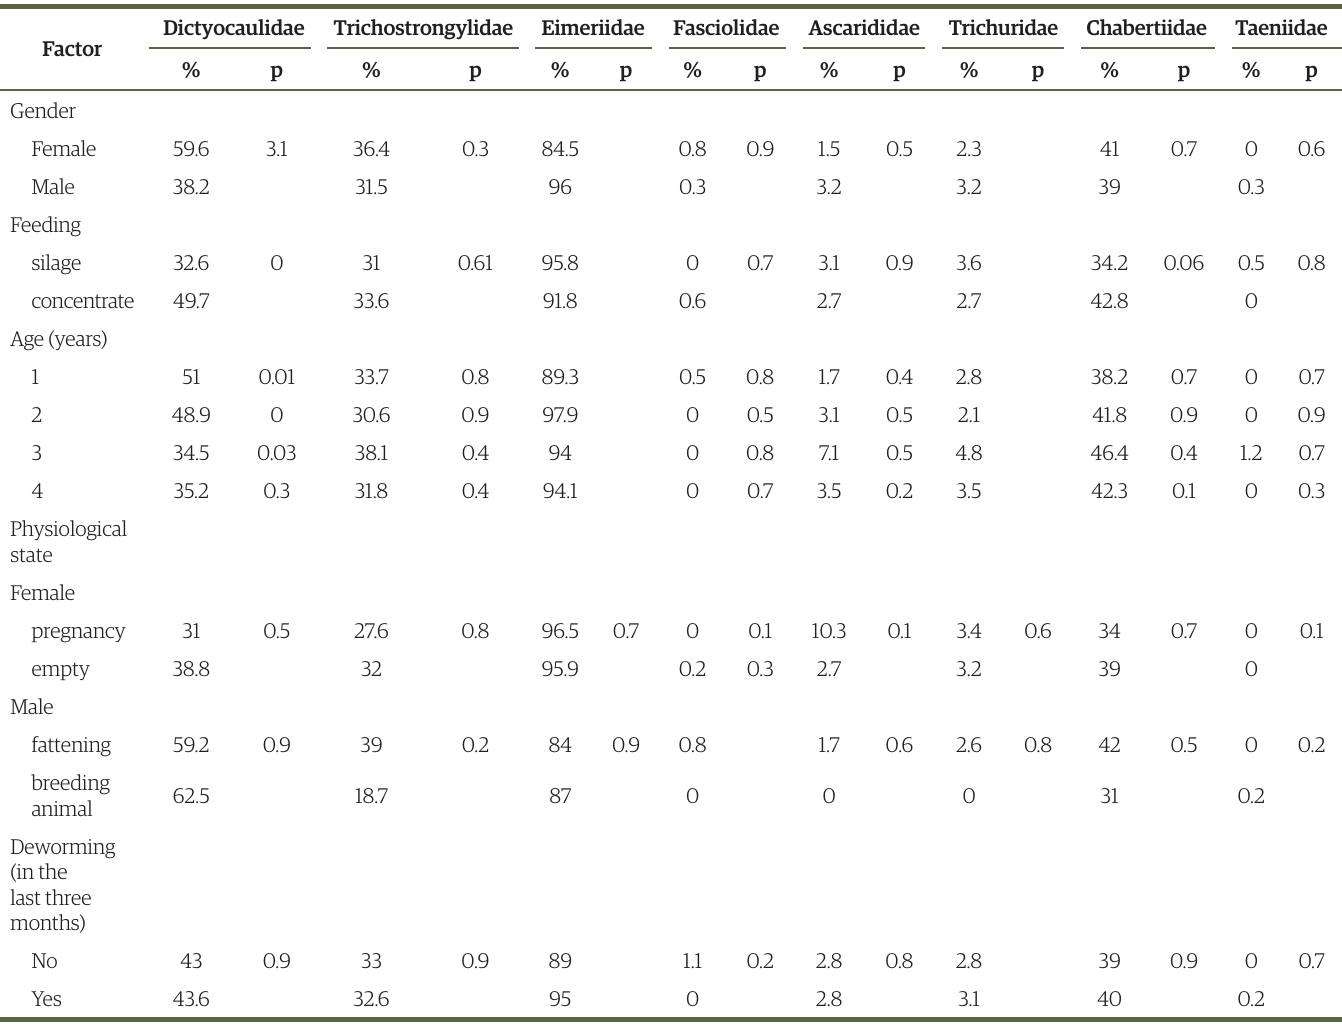
Table 2. Parasites families; positive prevalence rates and p value by sex, type of feeding, age, physiological state and deworming state. Dictyocaulidae Factor